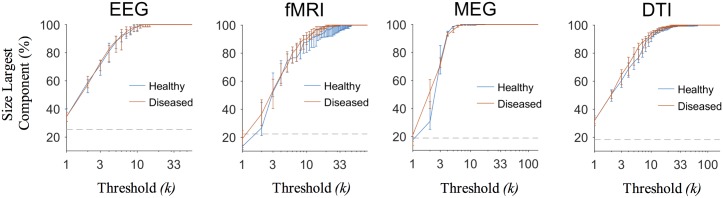
Size of the largest component in brain networks filtered with ECO and statistical comparison between groups.The size of the largest component is given as a percentage of total nodes. Blue lines stand for median values of the healthy group; red lines are median values of the diseased group. Vertical bars denote lower and upper quartiles. The dashed gray line shows the expected size for the giant component in a Erdos-Renyi random graph with p = 1/n). No statistical between-group differences for any threshold value were reported (Wilcoxon ranks-sum tests, P ≥ 0.01).